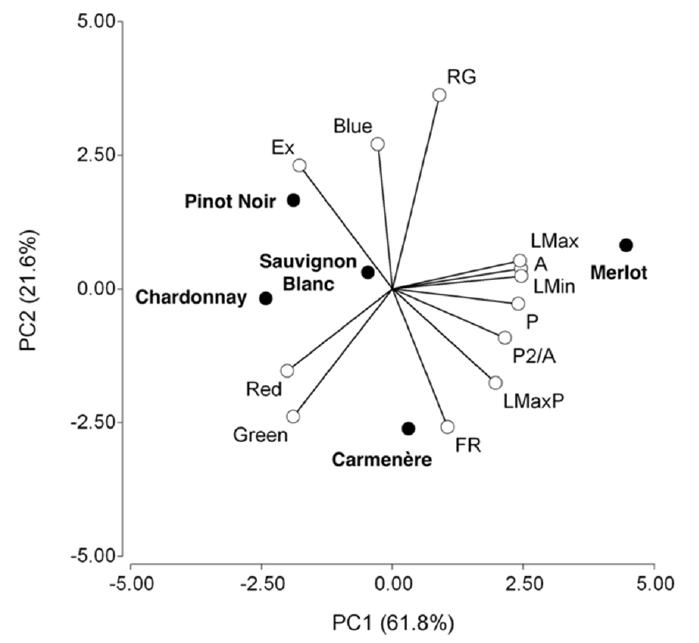
Figure 2. Principal component analysis (PCA) graph combining score plot and loadings for leaf morpho-colorimetric parameters obtained from five different grapevine varieties considering all data.